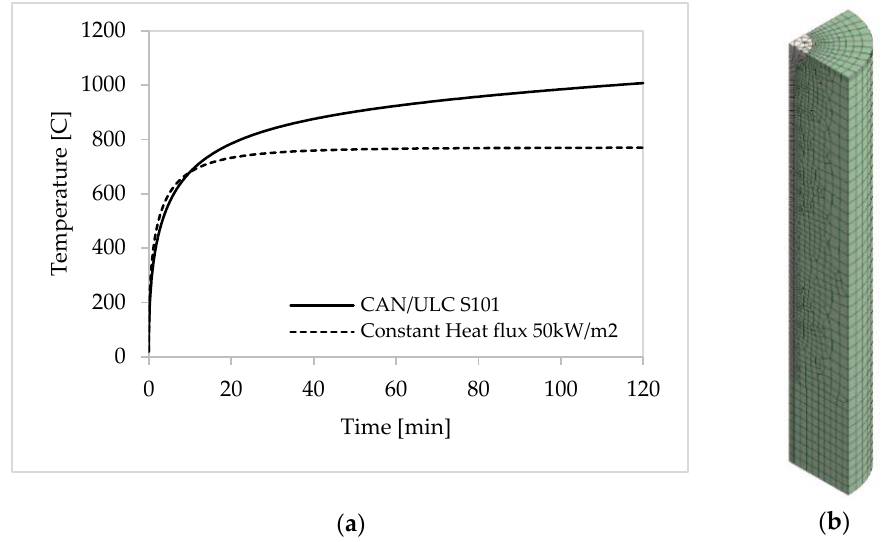
Figure 6. Major parameters used for FEM modeling: ( a ) Temperature–time curve applied at the surface of the specimen; ( b ) Meshing.